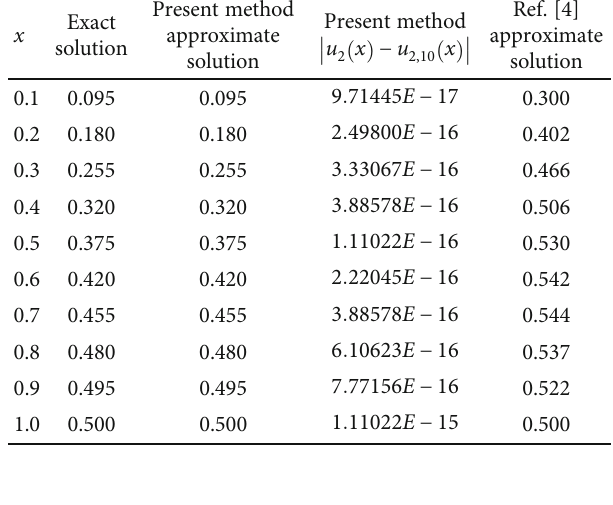
Table 6: Comparison of the numerical result of u